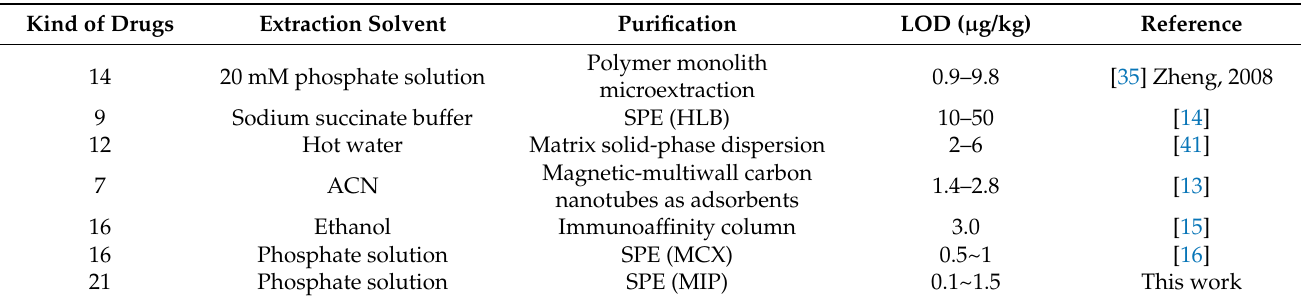
Table 4. Comparison of the proposed method with other reported